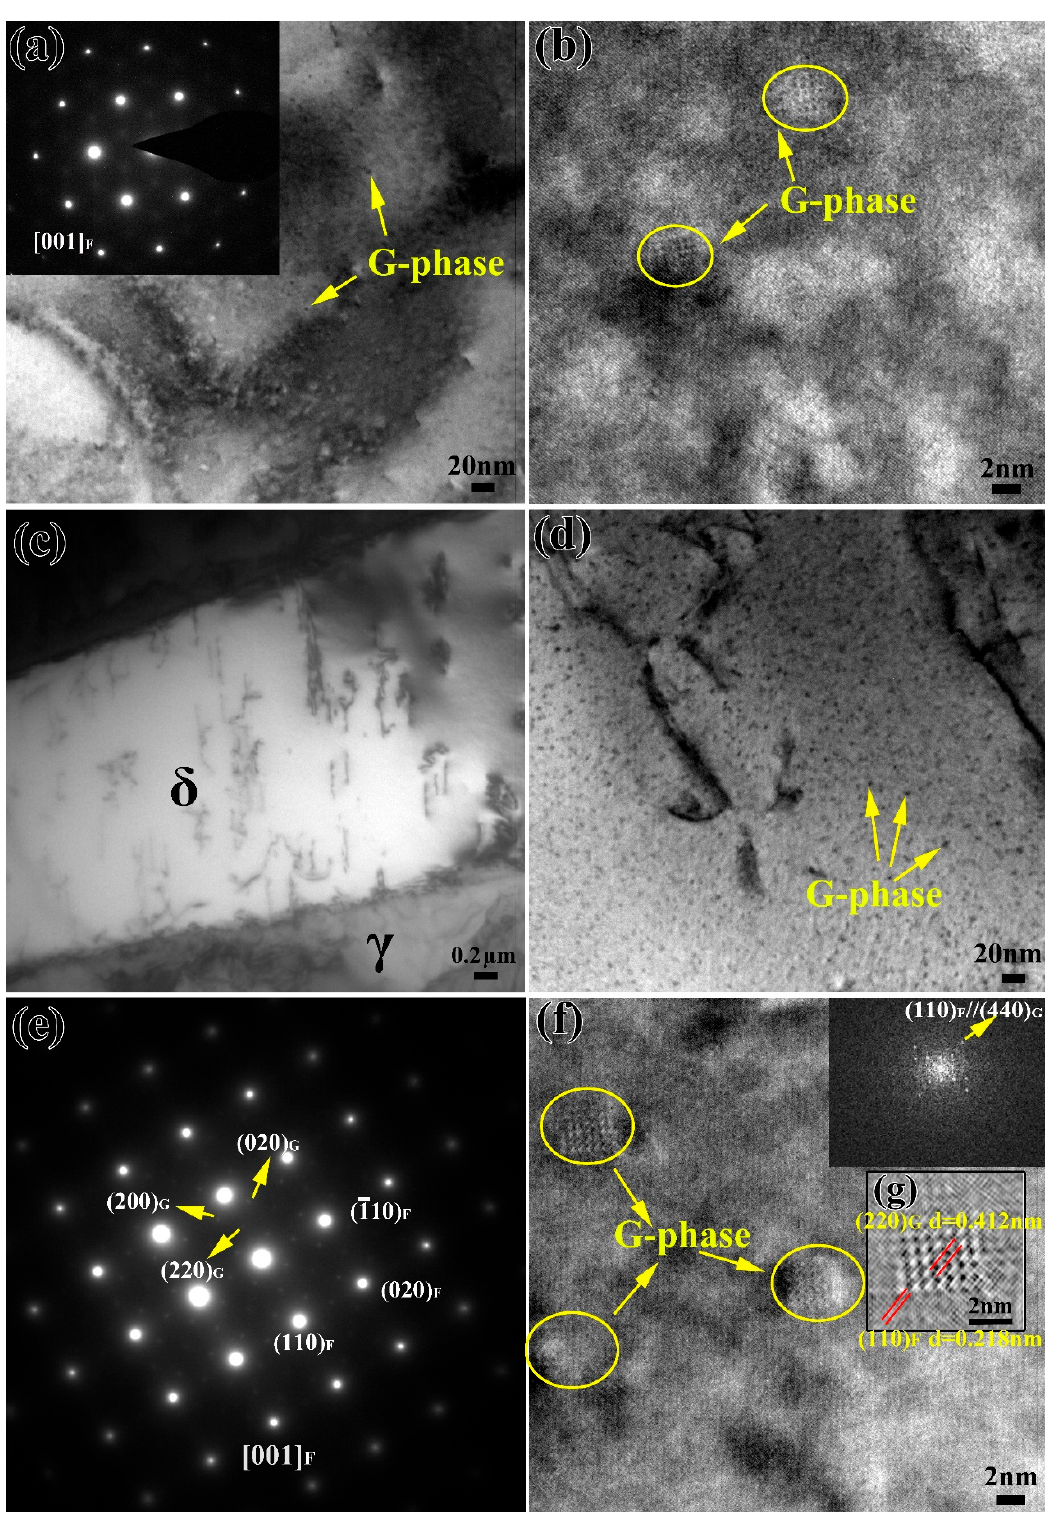
Figure 4. TEM and HRTEM images of stainless steel after aging for ( a , b ) 5000 h and ( c – g ) 10,000 h; the corresponding SAED, FFT and inverse FFT patterns are inserted.